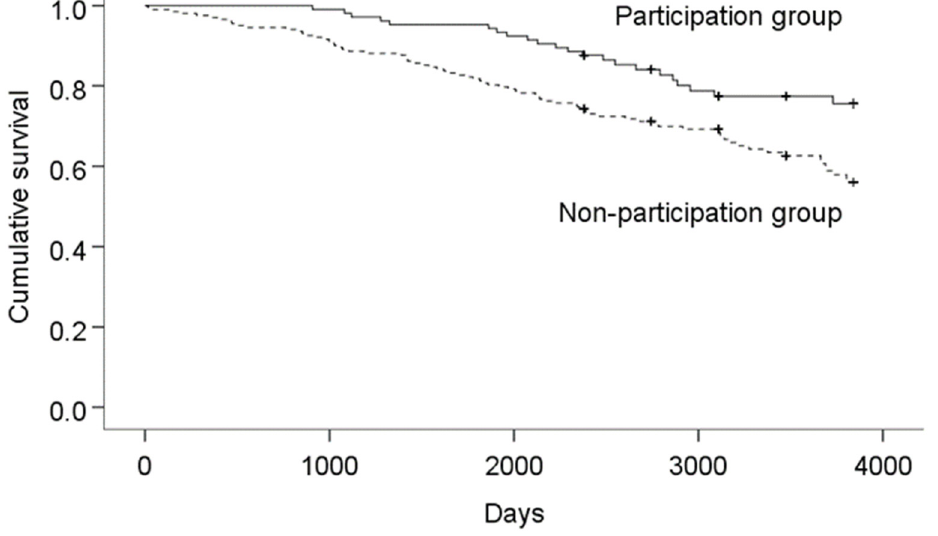
Figure 1. Comparison of survival duration between the participation and non-participation groups.